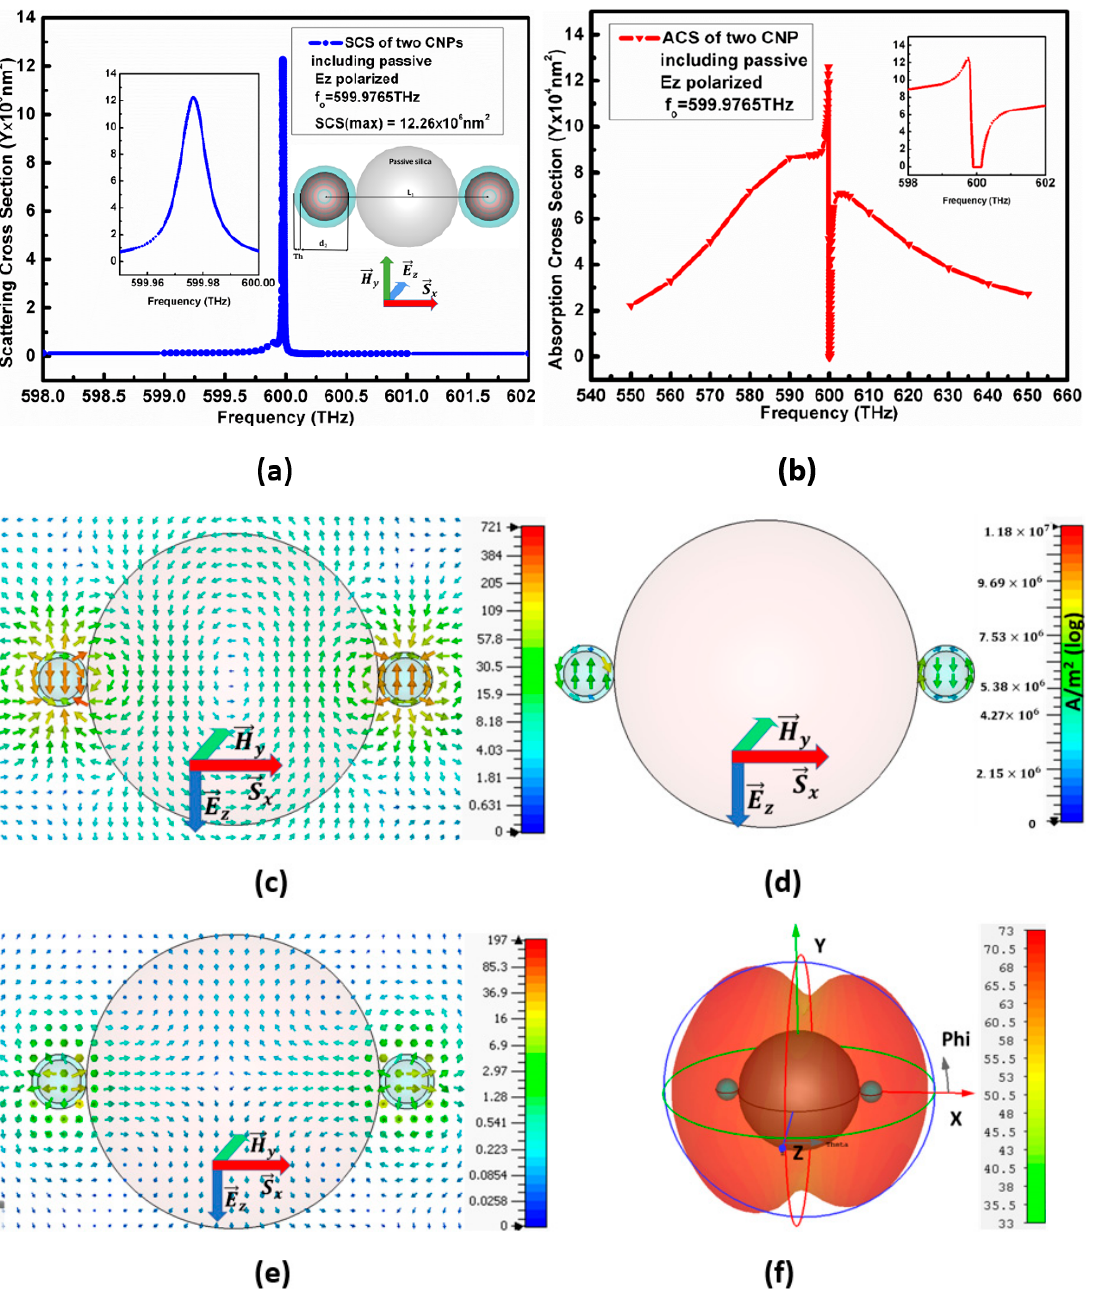
Figure 7. Represents ( a ) SCS peaks ( b ) ACS peak, ( c ) electric field, ( d ) electric current density, ( e ) power flow and ( f ) far-field pattern for configurations-II at resonance frequency. pattern for configurations-II at resonance